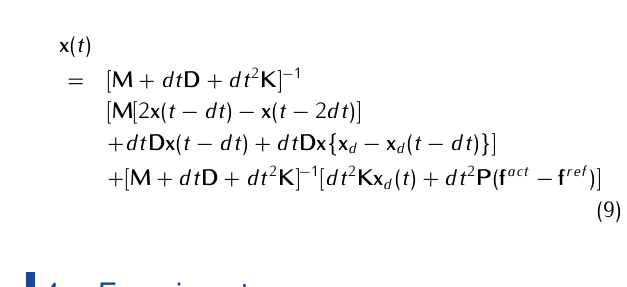
of the opposite end-effector, which is grasping a vegetable, because of the limitation of the joint angles. In addition, there is a possibility that